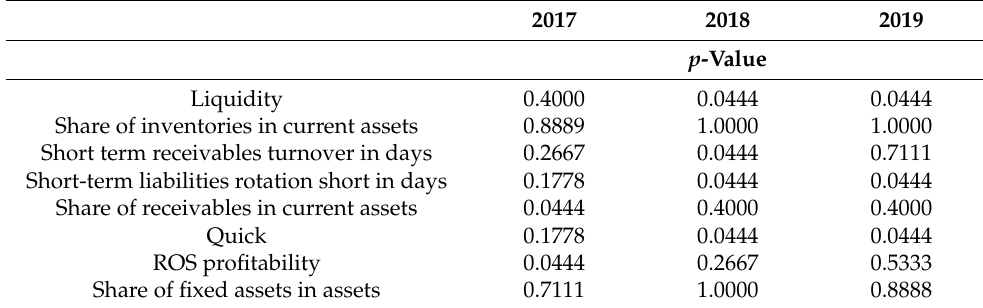
Table 2. Mann-Whitney U test results. Company size and differences in the level of selected indicators.